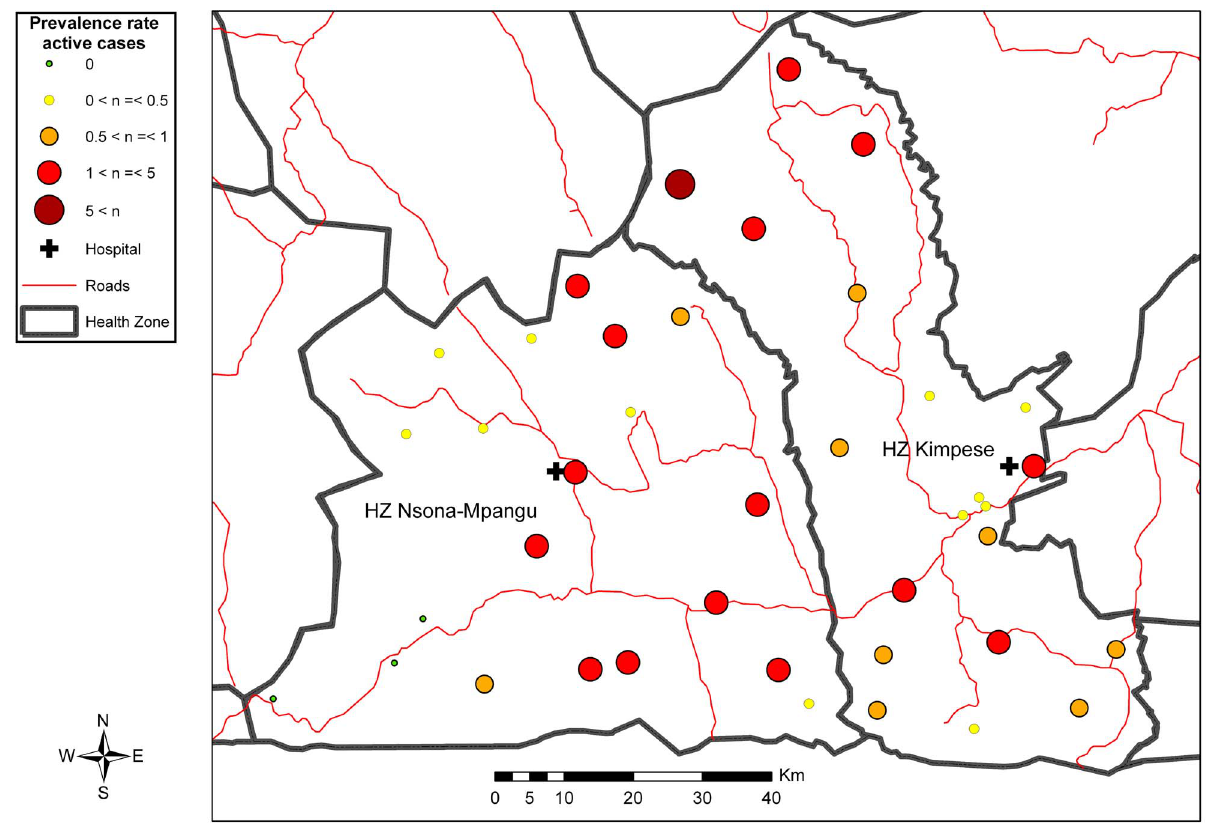
Figure 3. Distribution of active BU cases in the Songololo Territory, July–August 2008.